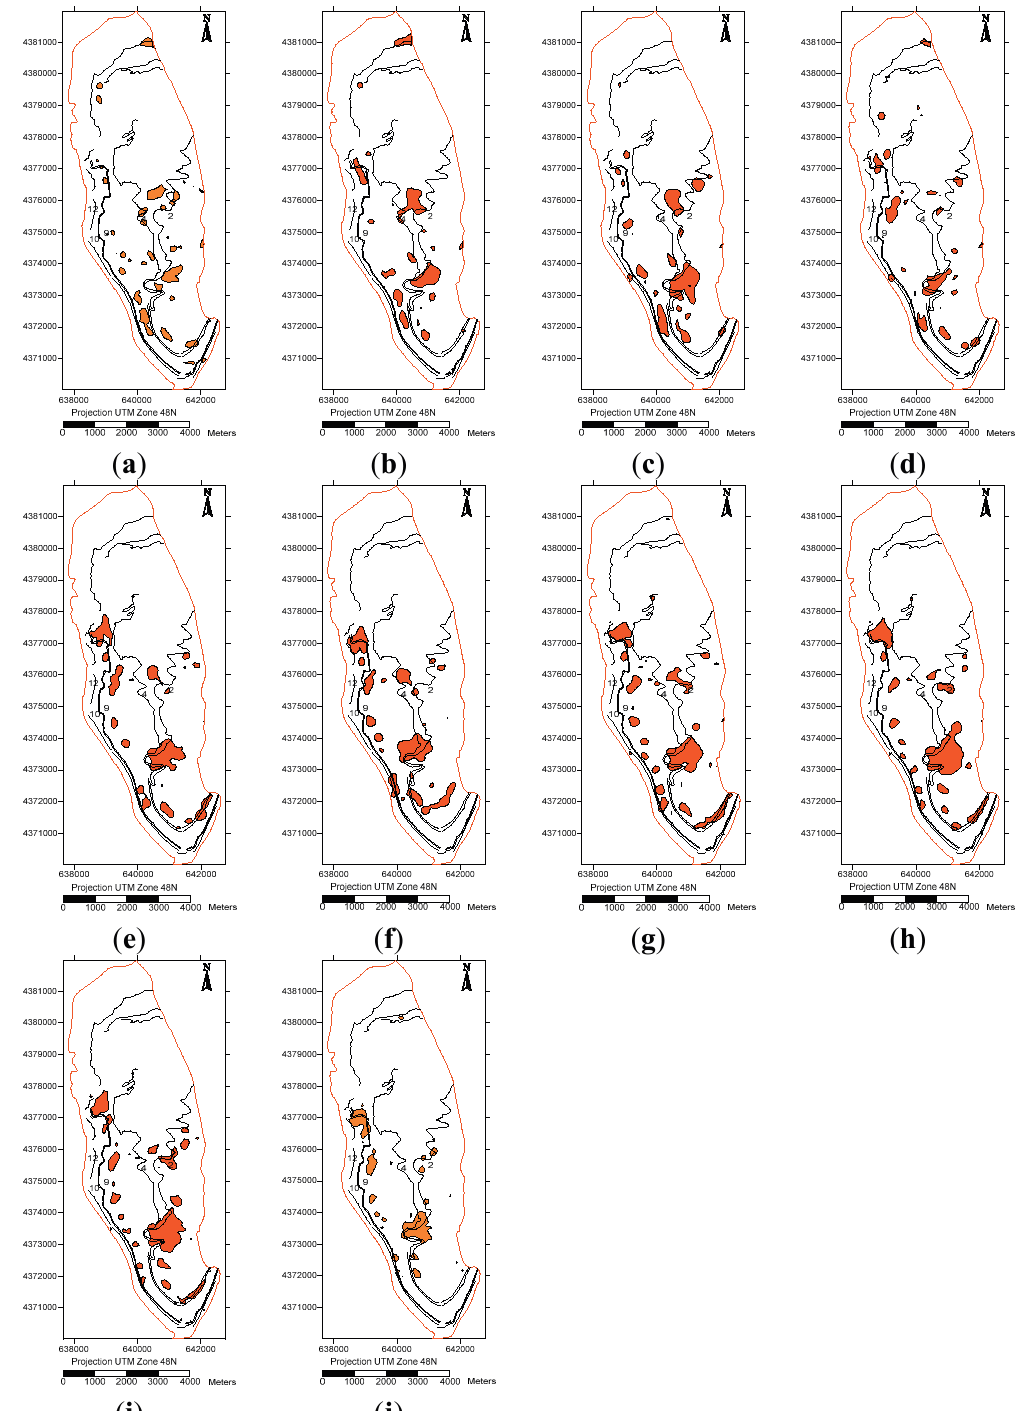
Figure 4. Thermal anomaly maps for the period 28 December 2006–21 April 2008 in the Wuda coal field. The dates of these maps (dd/mm/yyyy) are as follows: ( a ) 28 December 2006; ( b ) 14 February 2007; ( c ) 12 April 2007; ( d ) 22 June 2007; ( e ) 29 November 2007; ( f ) 8 December 2007; ( g ) 10 February 2008; ( h ) 29 March 2008; ( i ) 14 April 2008; ( j ) 21 April 2008. The orange areas present thermal anomalies that could indicate underground coal fires. Solid black lines demarcate the outcrops of coal seams numbered from east to west,